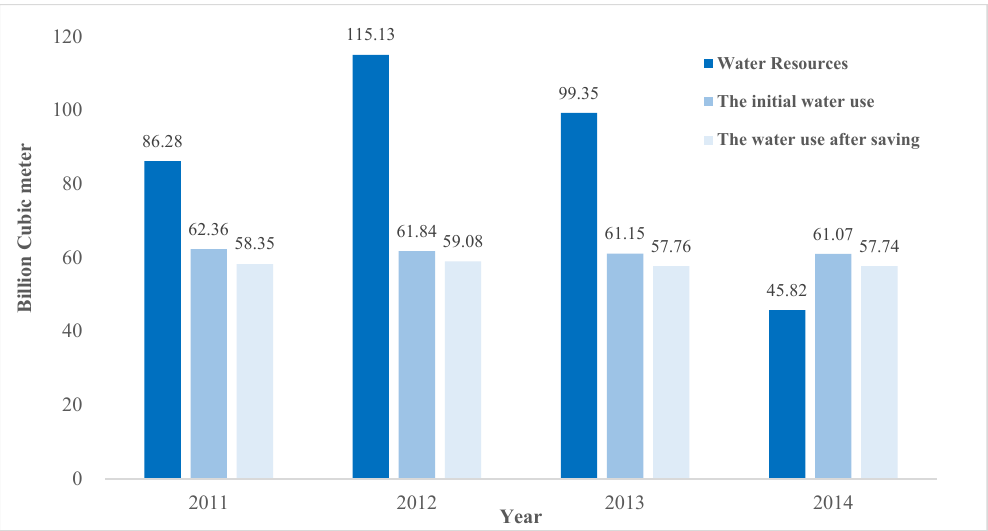
Figure 3. Comparison of water resources amount, initial water use amount, and water use after curtailment of Bohai Bay city agglomeration from 2011 to 2014. Table 3. Changes of maximum potential savings of water use in Bohai Bay city agglomeration (in billion cubic meters), 2011–2014.